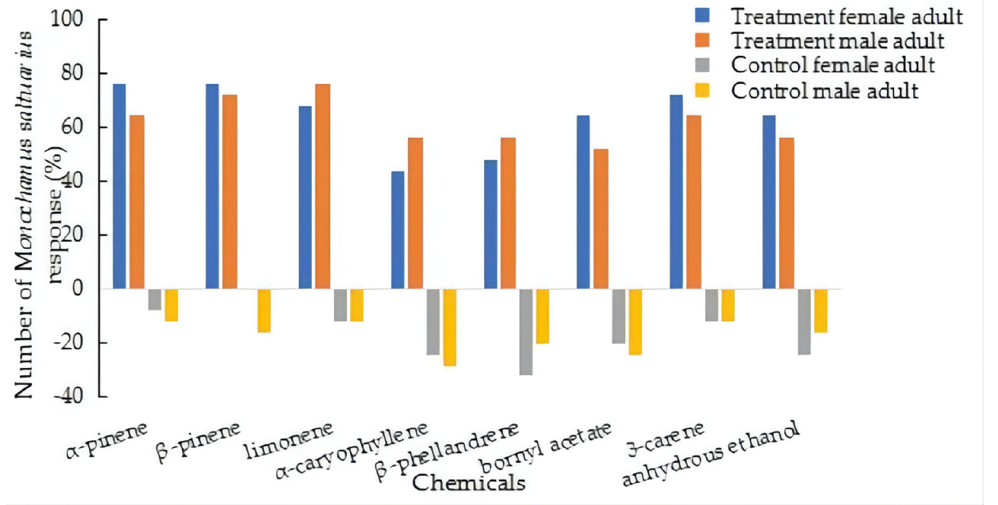
Figure 3. Response of Monochamus saltuarius to different host pine tree volatiles.